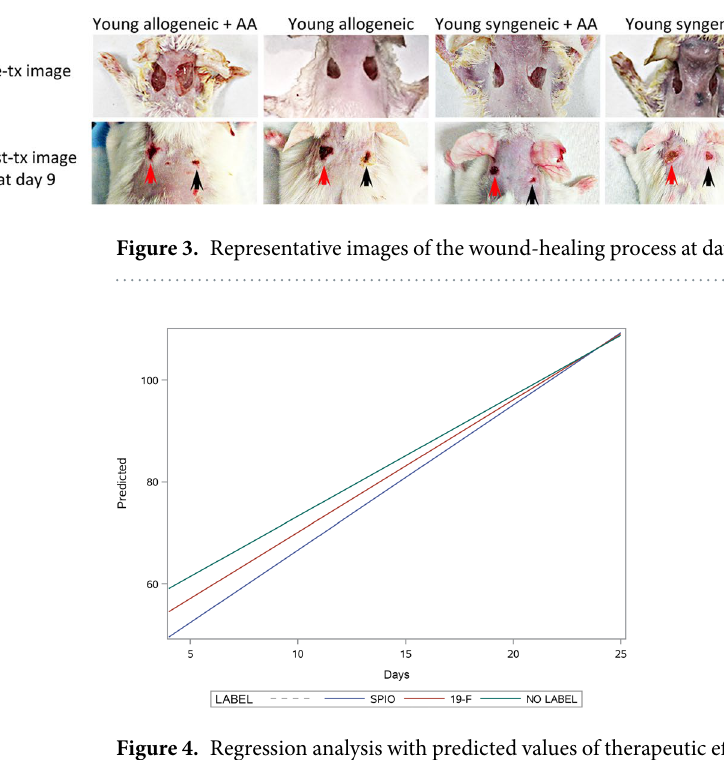
Figure 4. Regression analysis with predicted values of therapeutic effect (wound closure) for the different imaging groups versus time, expressed as days.